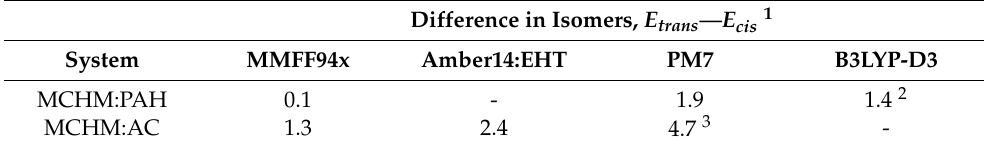
Table 1. Differences in physisorption potentials between MCHM isomers and carbonaceous surfaces.